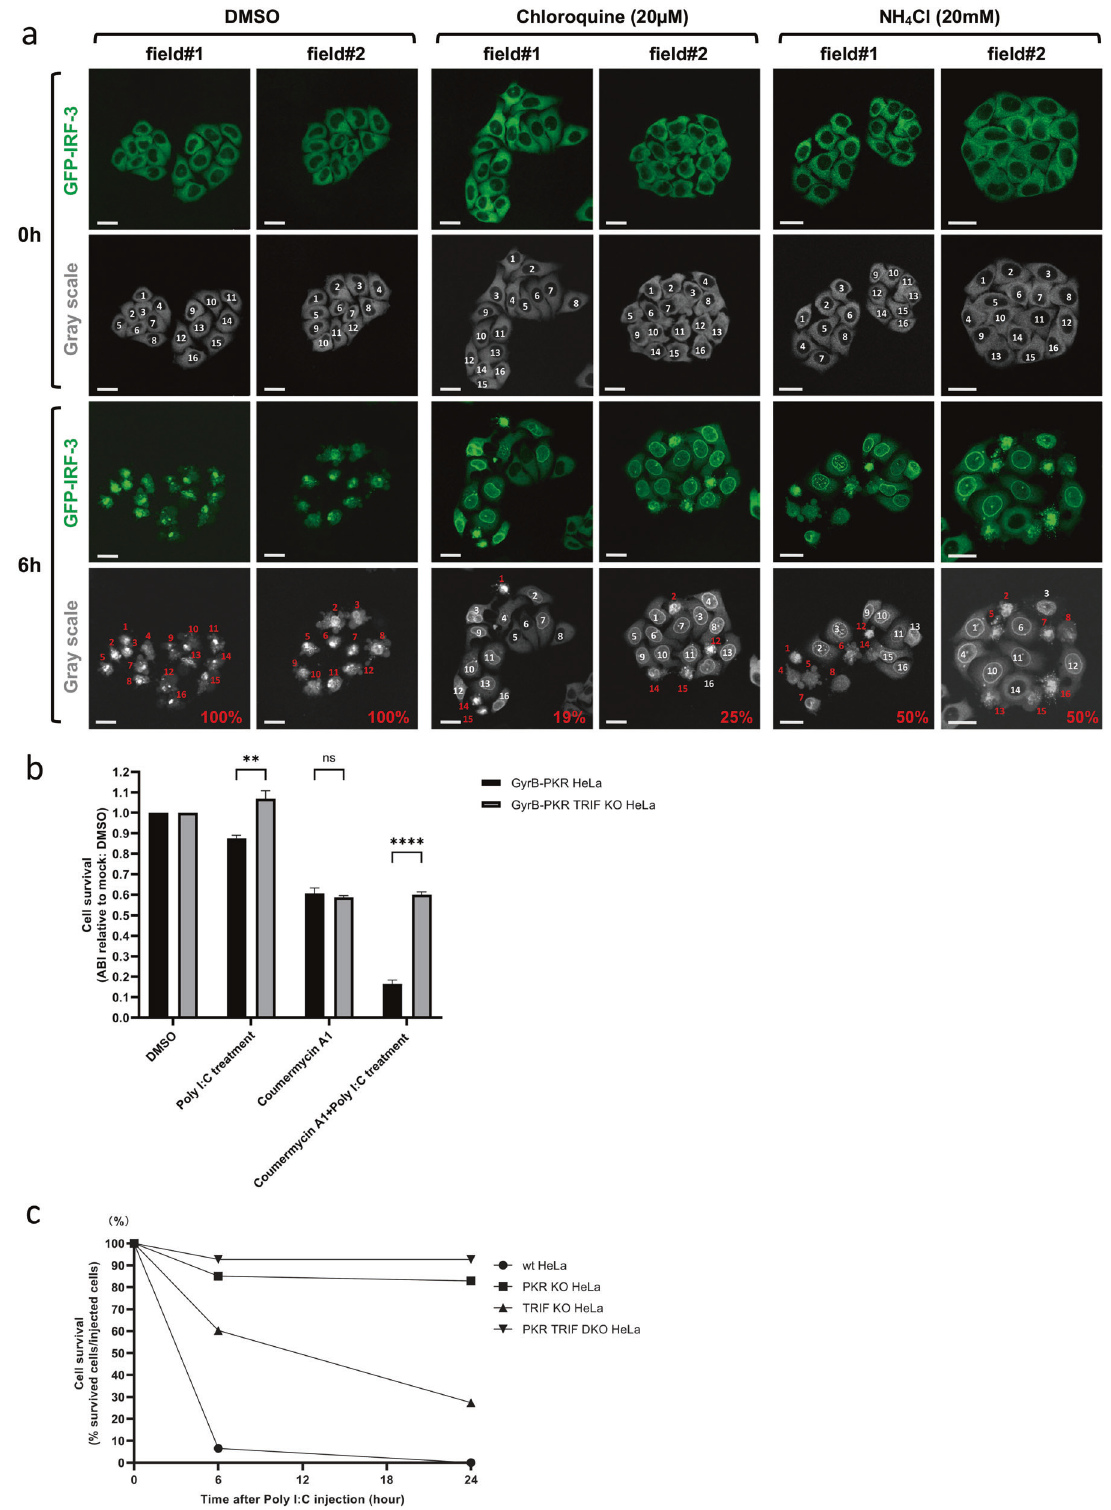
Fig. 5 Involvement of TLR3 signaling in cell death induced by cytoplasmic poly I:C. a GFP-IRF-3 HeLa cells were treated with DMSO, chloroquine (20 μ M for 6 h), or NH 4 Cl (20 mM for 6 h) and then injected with poly I:C (1 μ g/ μ l). GFP images of live cells were taken 0 and 6 h after the poly I:C injection. In each fi eld, cells were numbered, assessed as dead (red) or alive (white), and % cell death was calculated. Scale bar = 25 µm. b GyrB-PKR HeLa and GyrB-PKR TRIF KO HeLa cells were treated with the indicated chemicals for 6 h and examined for cell survival. The means ± SEM of three independent experiments are shown; data were analyzed by a two-way ANOVA followed by Tukey ’ s multiple comparisons test; ** P < 0.01, **** P < 0.0001; ns not signi fi cant. c Wild-type, PKR KO, TRIF KO, and PKR TRIF DKO HeLa cells were injected with poly I:C (1 μ g/ μ l), observed live for cell death, and % cell survival at the indicated time points was quanti fi ed.